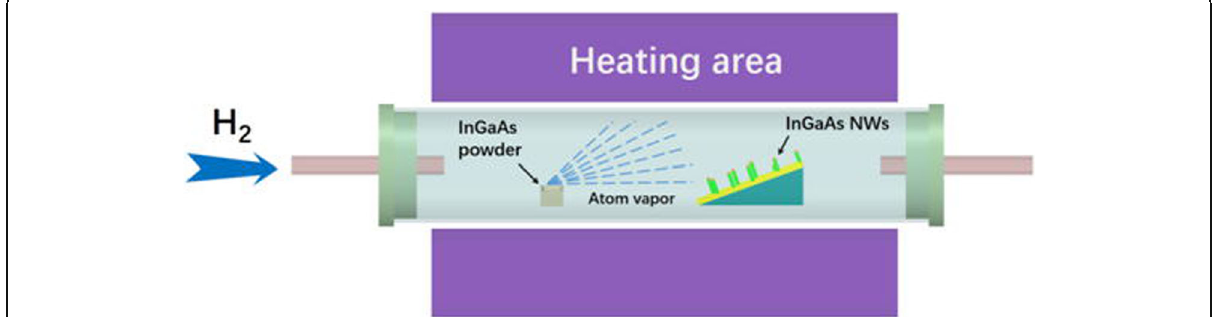
Fig. 1 Schematic diagram of the experimental setup for InGaAs